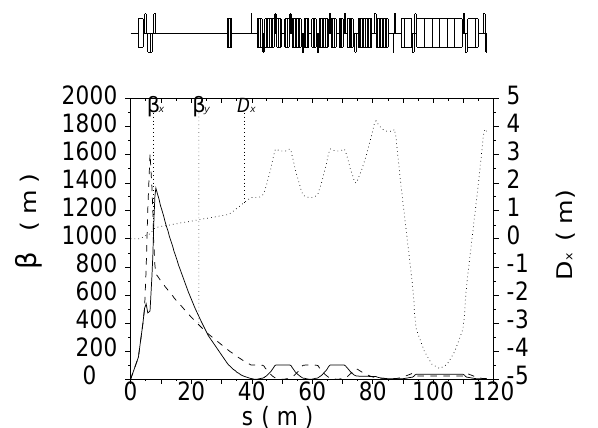
FIG. 44. Example (a): 14 cm b (cid:1) mode showing half of the IR, local chromatic correction, and one of three arc